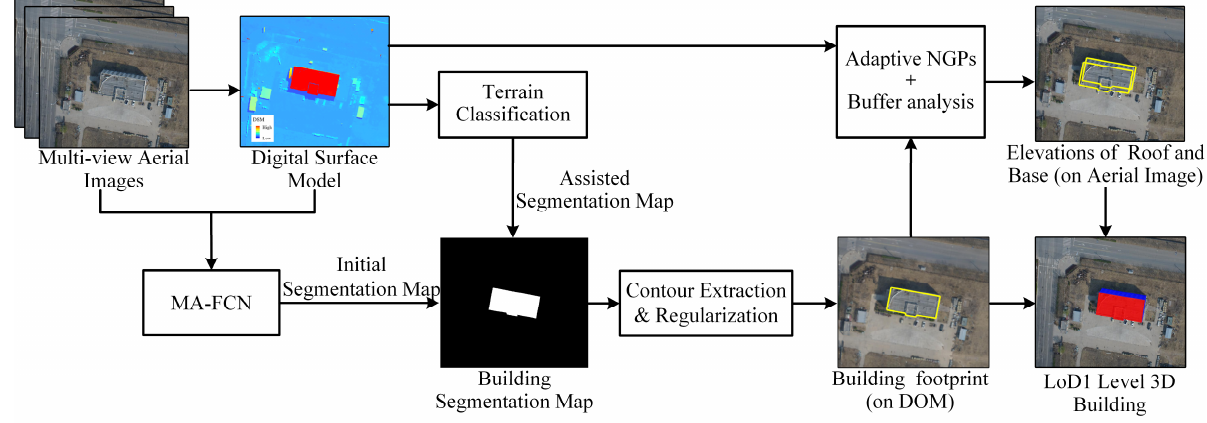
Figure 1. The workflow of our proposed 3D building reconstruction